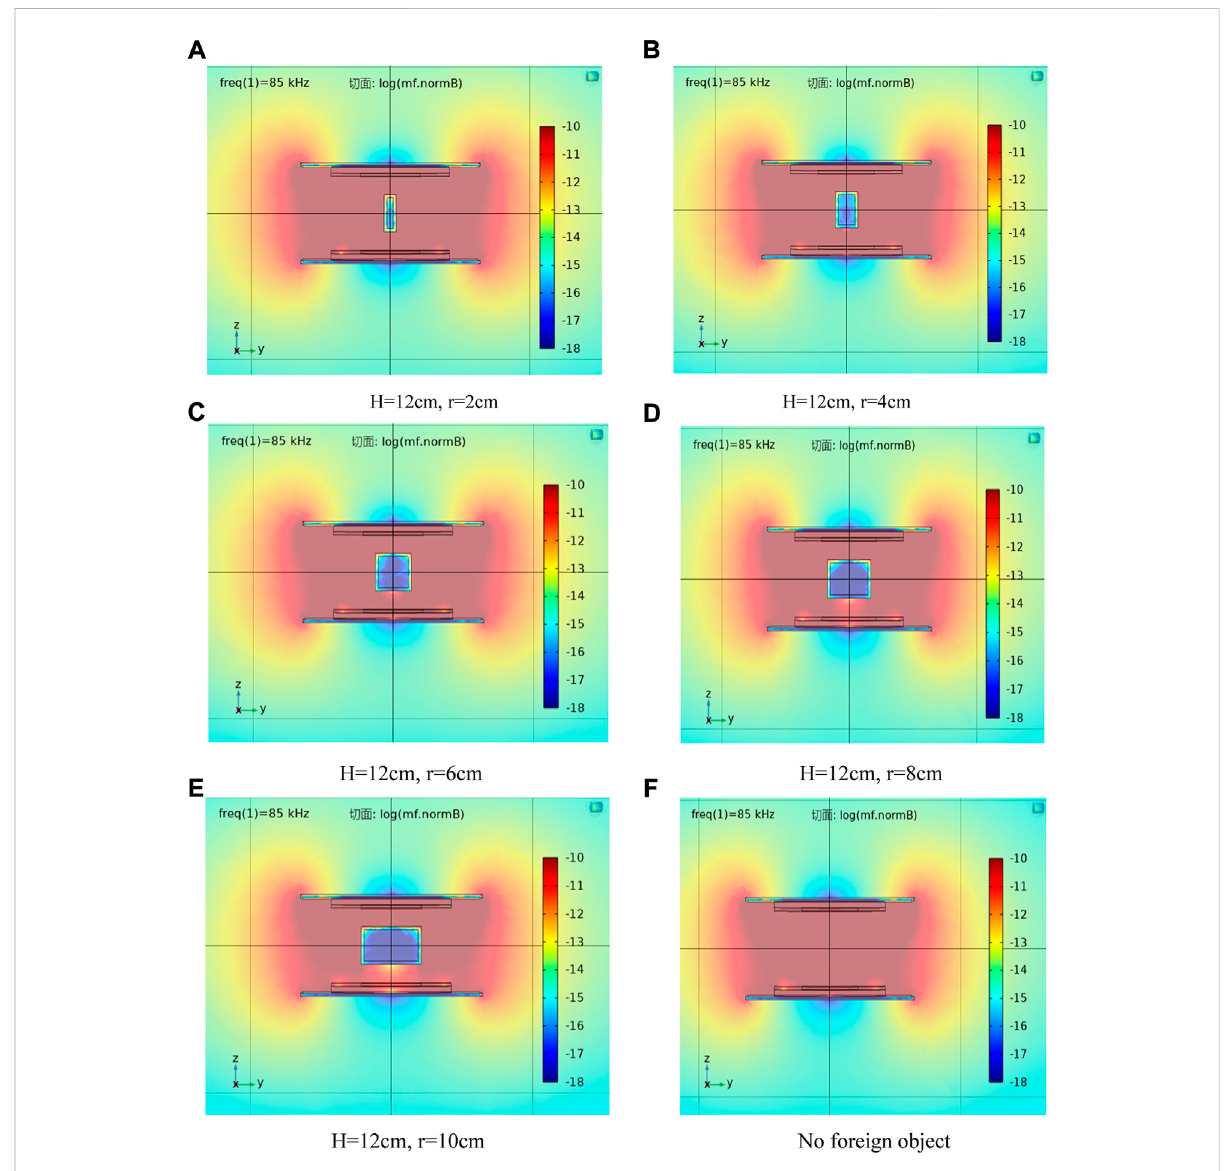
FIGURE 5 Magnetic fl uxdensityofthecouplerchangeswhentheheightoftheforeignobjectchanges. (A) H=12 cm,r=2 cm. (B) H=12 cm,r=4 cm. (C) H = 12 cm, r = 6 cm. (D) H = 12 cm, r = 8 cm. (E) H = 12 cm, r = 10 cm. (F) No foreign